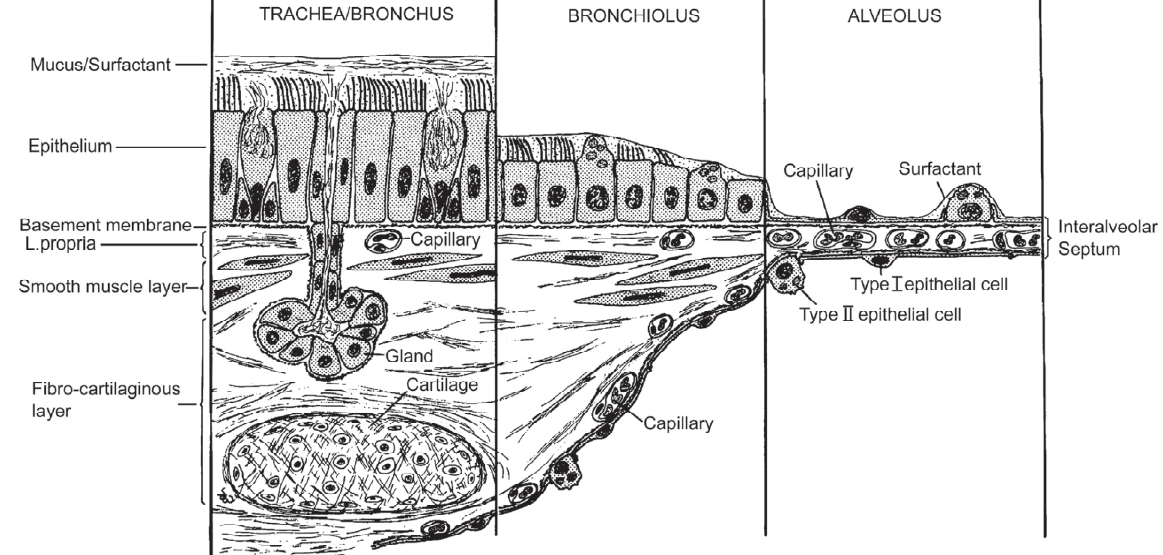
Figure 1. Drawing of the airway wall structure at the three principal levels from